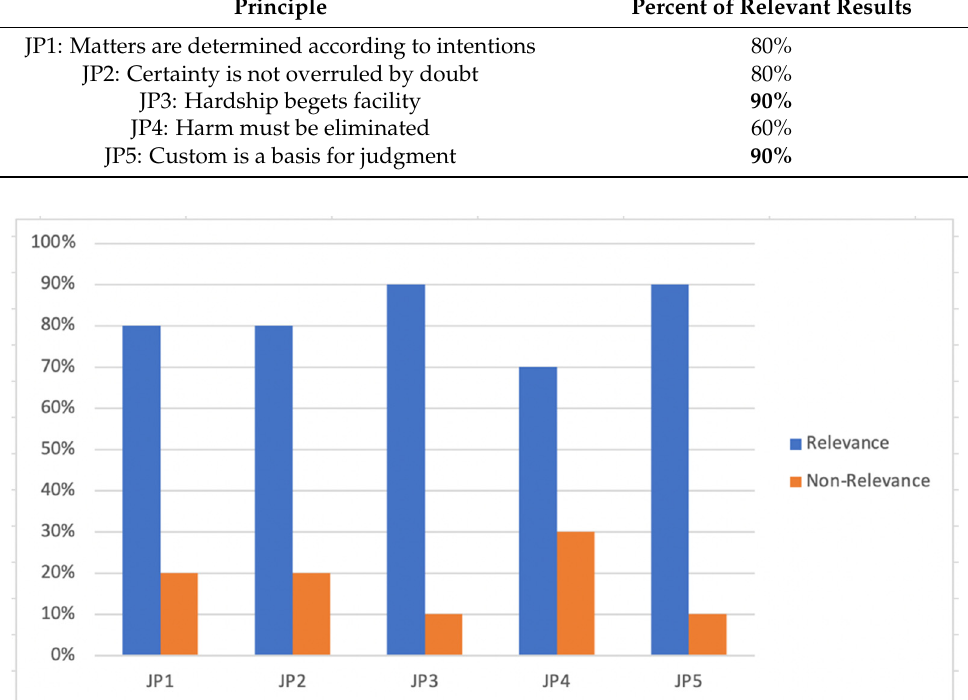
Figure 3. Relevance evaluation of the JCs to JPs for each of the five principles.